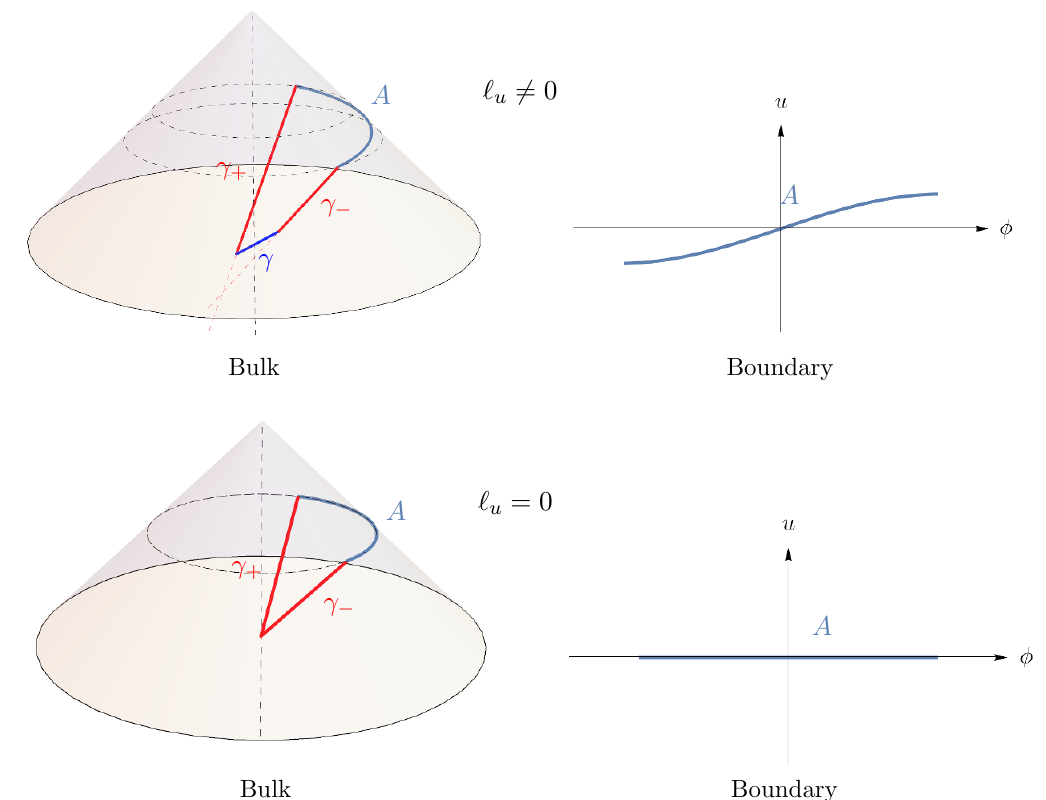
Figure 1 . Examples of Ryu-Takayanagi surfaces in 3d Minkowski